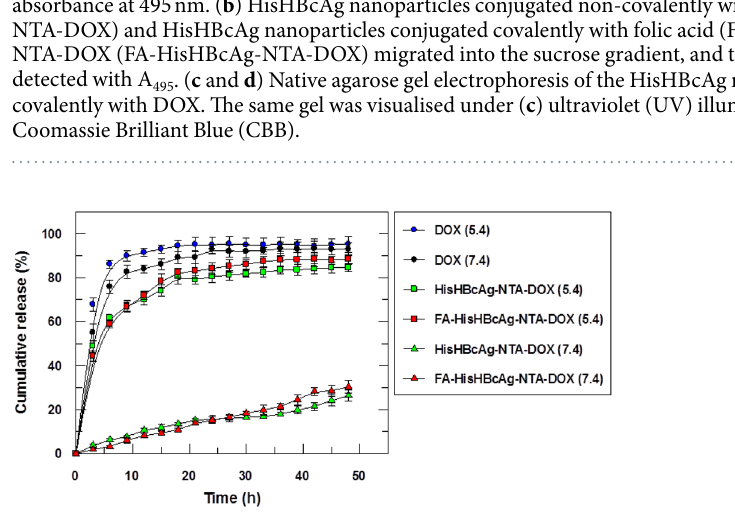
Figure 6. Doxorubicin release profile of the His-tagged VLNPs at different pH. The release profiles of free doxorubicin (DOX), HisHBcAg nanoparticles conjugated non-covalently with NTA-DOX (HisHBcAg-NTA- DOX) and HisHBcAg nanoparticles conjugated covalently with folic acid (FA) and non-covalently with NTA- DOX (FA-HisHBcAg-NTA-DOX) at pH 5.4 and 7.4. More than 80% of the free DOX was released after 5 h at pH 5.4 and pH 7.4, whereas approximately 80% of the conjugated DOX on HisHBcAg nanoparticles was released after 16 h at pH 5.4. Data are expressed as mean ± standard deviation (n =